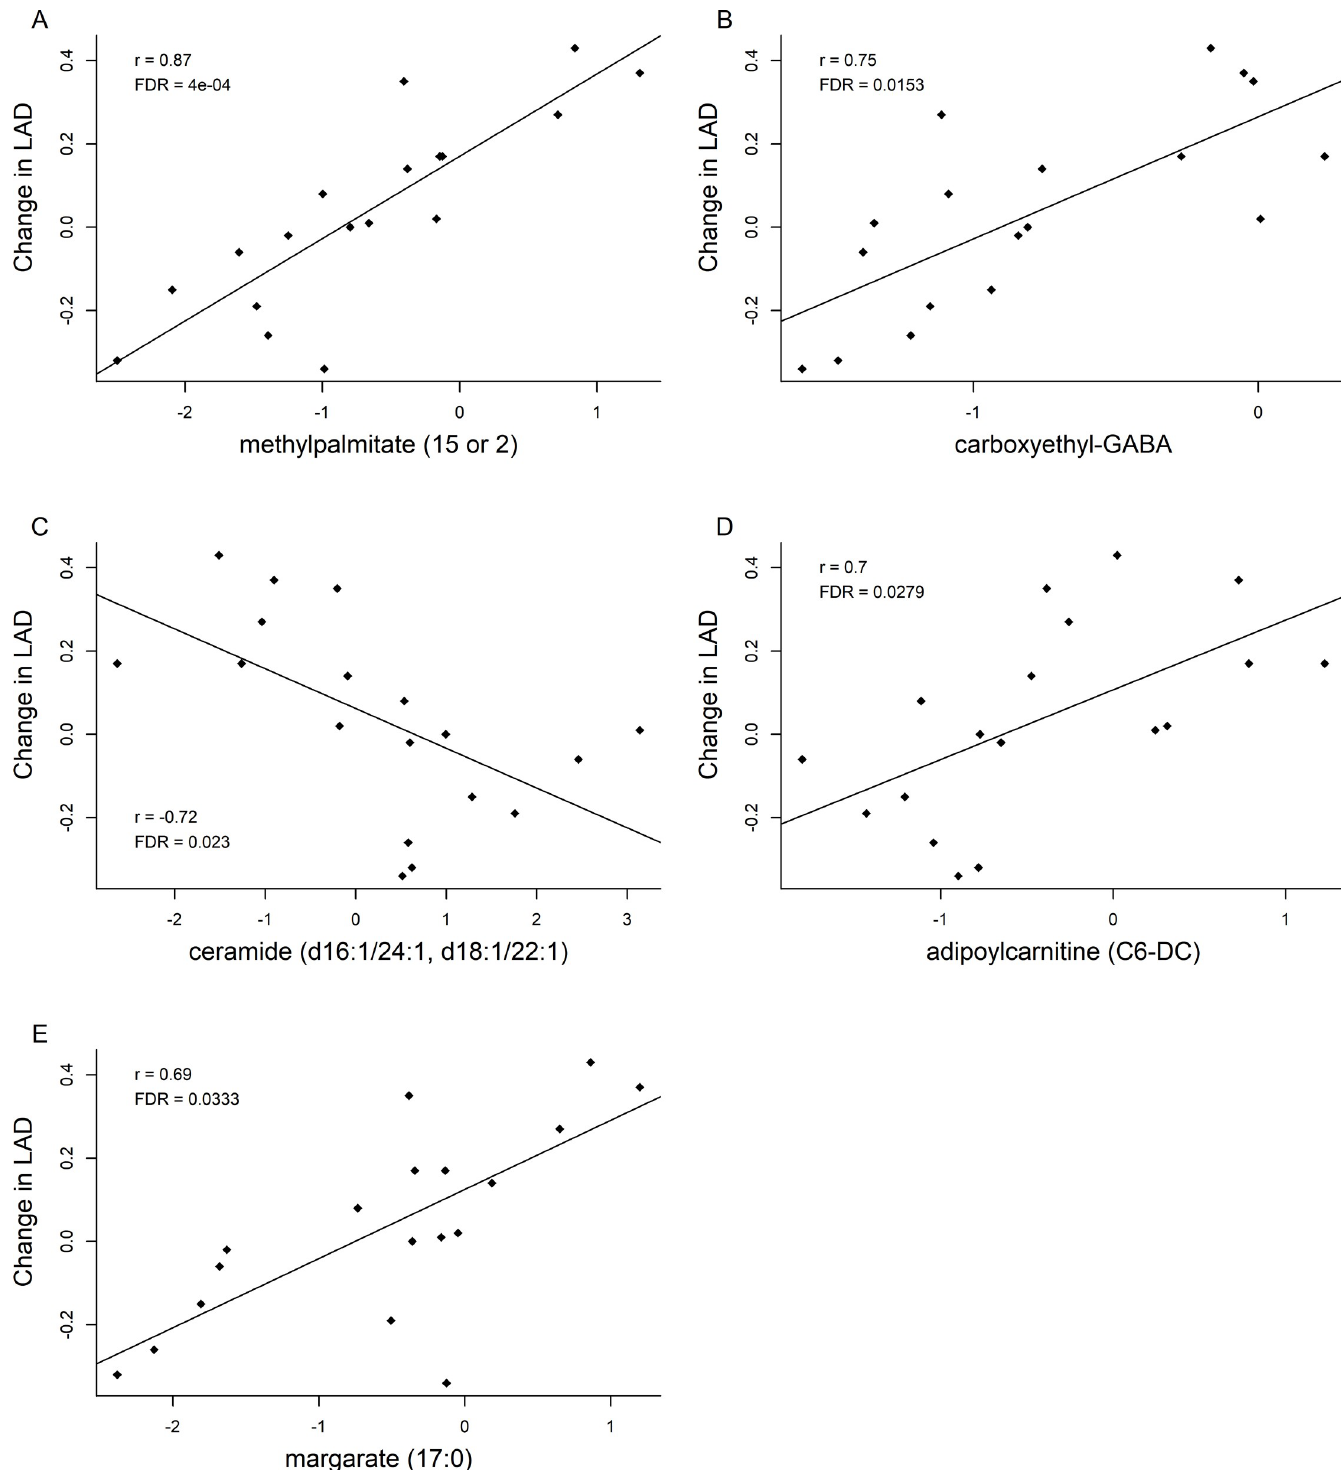
Fig 4. Scatterplots of changes between left atrial diameter (LAD) and (A) methylpalmitate, (B) carboxyethyl-GABA, (C) ceramide, (D) adipoylcarnitine, and (E) margarate. Correlation coefficients (r) and adjusted p-values (FDR) from Spearman’s correlation analysis are shown in the plots. A linear regression line is also drawn in each